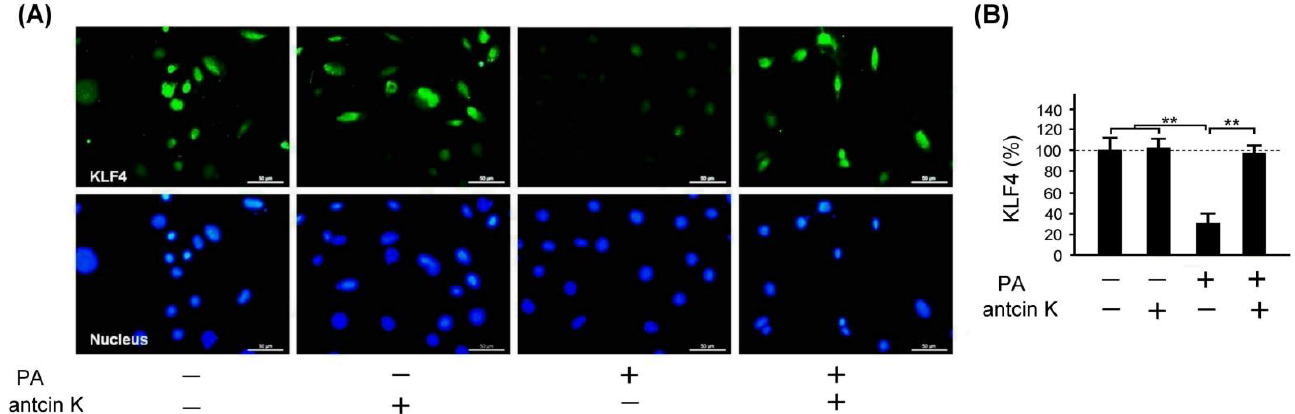
Figure 10. Antcin K treatments effectively enhanced the expression of KLF4 in palm oil-treated vascular endothelial cells. ( A ) Immunofluorescence staining to examine expressions of KLF4 (green) and nuclei (blue, DAPI) in vascular endothelial cells with and without palm acid oil (PA) treatment, and with and without antcin K treatments. ( B ) Comparison of the quantified expression of KLF4 of vascular endothelial cells with and without 0.75 mM palm acid oil treatment, and with and without 20 μ g/mL antcin K treatment ( n = 3 for each group; values are presented as mean ± SEM, ** p < 0.01, one-way ANOVA followed by the Student – Newman – Keuls multiple comparison post hoc test).